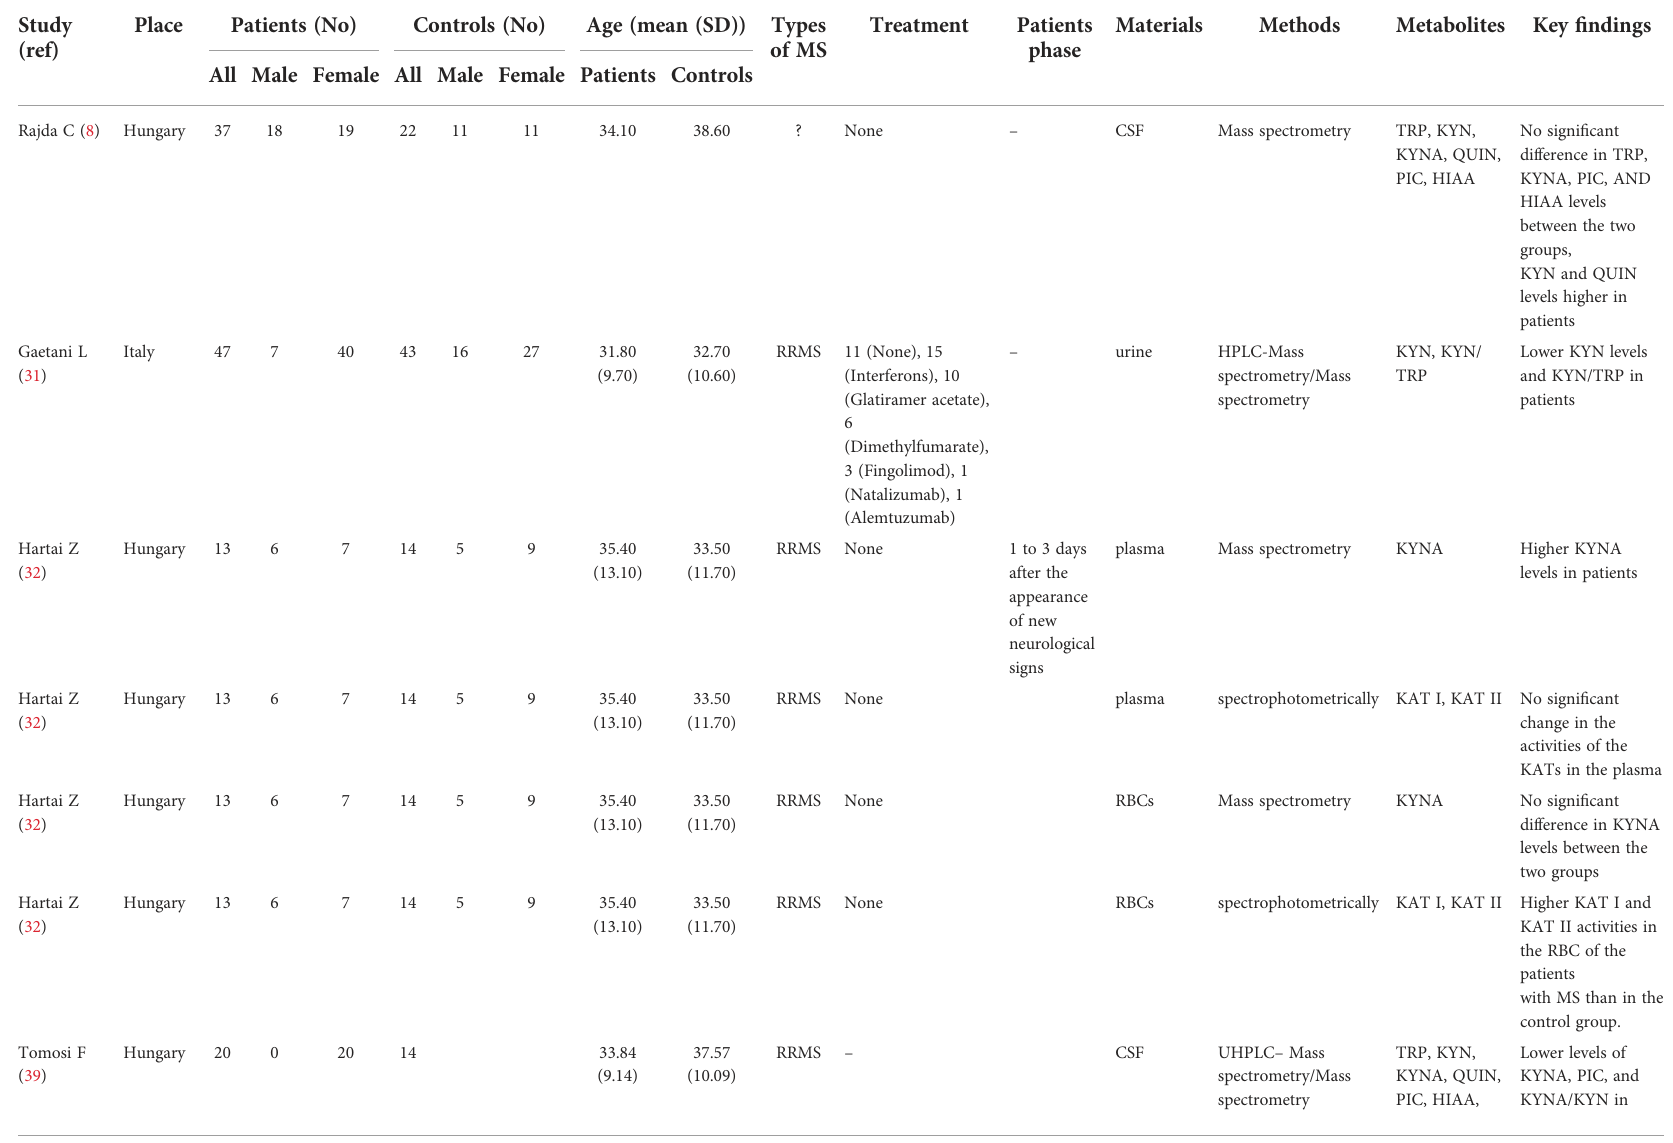
TABLE 1 Summary of the main fi ndings from studies included in the systematic